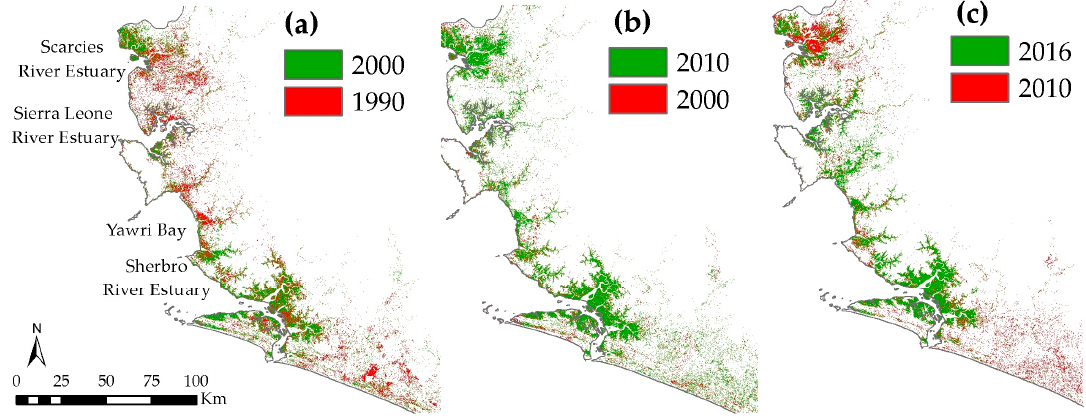
Figure 6. Decadal changes in mangrove extents in the Sierra Leone coastal landscape complex (SLCLC) during ( a ) 1990–2000, ( b ) 2000–2010, ( c ) 2010–2016.